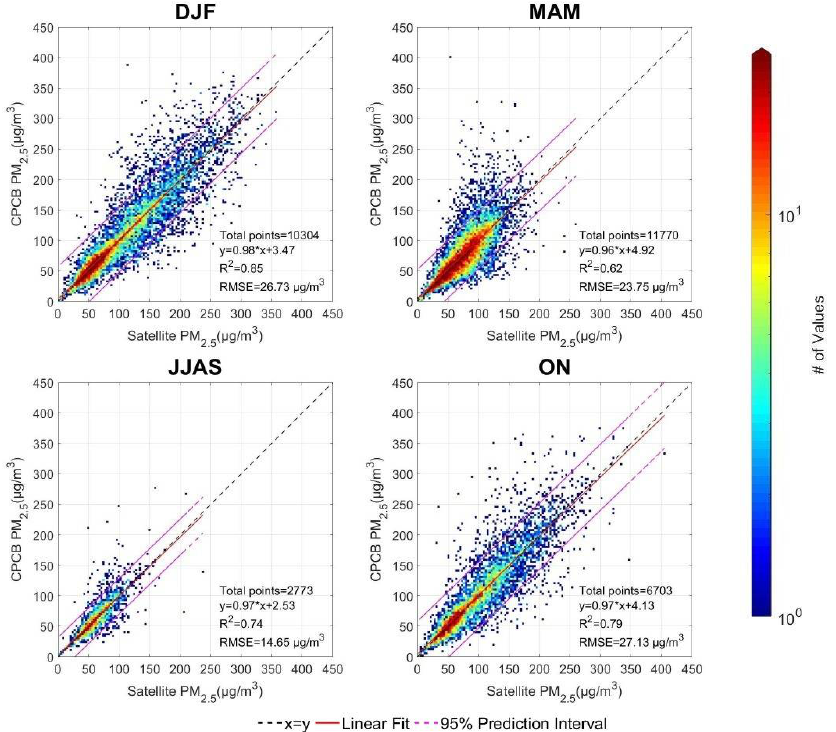
Figure A6. Regression statistics of the satellite-based daily PM 2.5 with measurements from Central Pollution Control Board (CPCB) sites for the winter (DJF), pre-monsoon (MAM), monsoon (JJAS) and post-monsoon (ON) seasons over India. Remote Sens. 2020 , 12 , x FOR PEER REVIEW